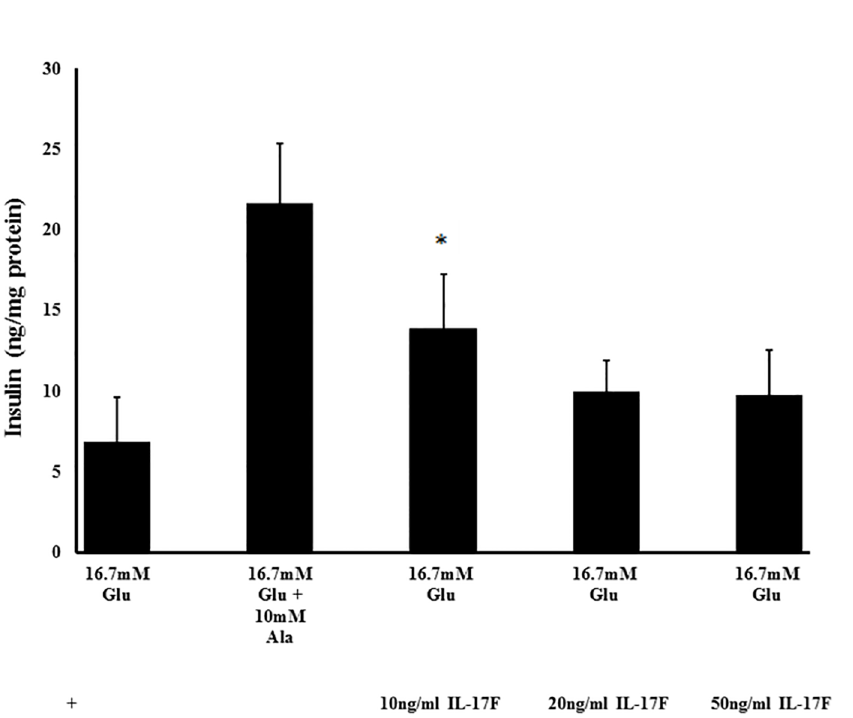
Fig 5. The effect of 20 h treatment with IL-17F on insulin secretion in BRIN-BD11 cell line. Values are mean ± standard deviation (n = 4). (cid:3) p < 0.05. ANOVA was applied across groups with post-hoc Bonferroni test for comparison of treatments (10, 20 and 50 ng/mL IL-17F) with 16.7mM glucose (control). Cells were incubated for 20 h with 10, 20 and 50 ng/mL IL-17F, and stimulated with 16.7 mM glucose to determine insulin secretion. Overall p = 0.000041. (cid:3) p = 0.043 where treatment with 10 ng/mL IL-17F is significantly increased in comparison to control of 16.7mM glucose.